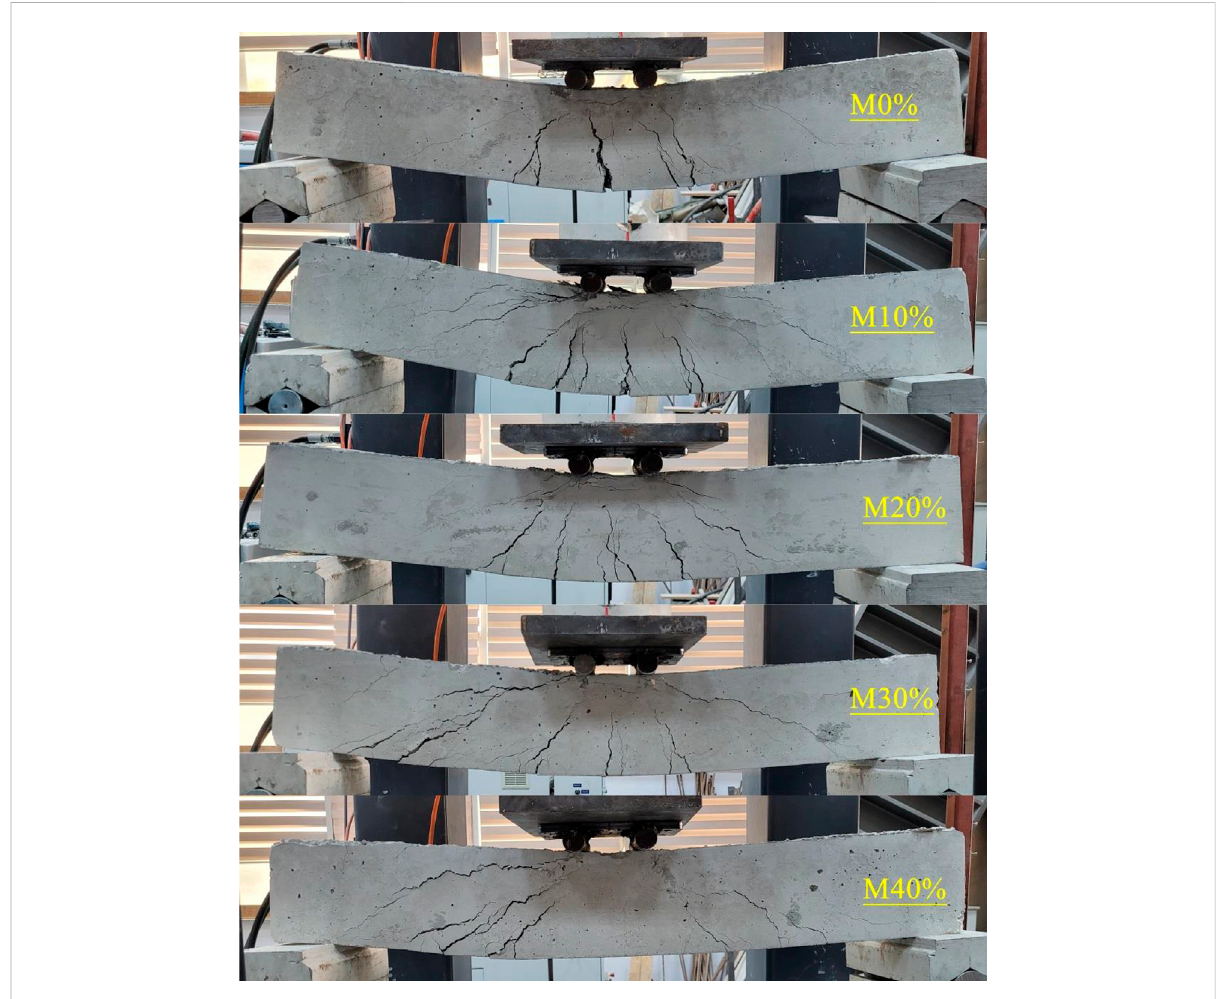
33.51 kN, 31.41 kN and 22.21 kN for V 8-M0%, V 8-M10%, V 8-M20%, V 8-M30%, and V 8-M40%. Then, 4.97 cm, 5.8 cm, 6.12 cm, 5.80 cm, and 5.09 cm bending is observed at maximum vertical load for V 8-M0%, V 8-M10%, V